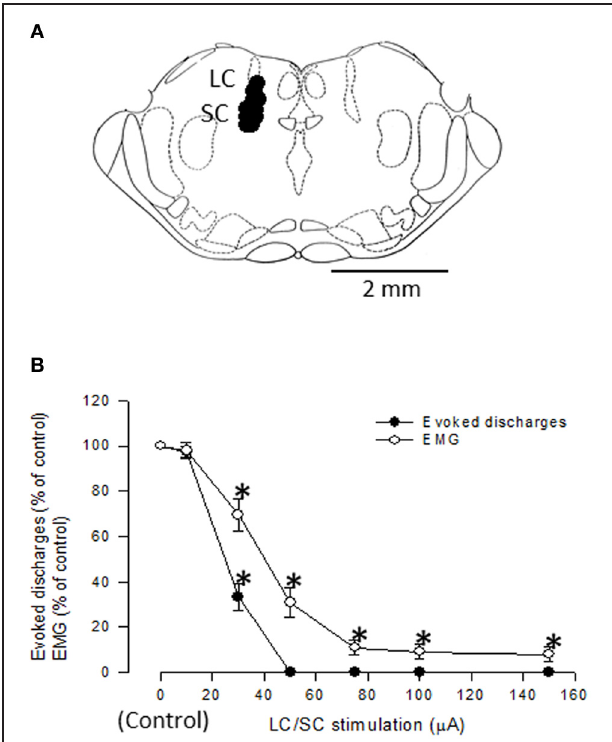
FIGURE 7 | (A) Localization of LC/SC stimulation sites ( n = 12). Each closed circle represents one animal. The rostrocaudal extension of the stimulation sites was 9 . 6 ± 0 . 1mm caudal to the bregma. Only data from rats in which the tip of the stimulating electrode was located within the LC/SC were adopted. (B) Graphs summarizing the effects of varying stimulus intensities of LC/SC stimulation on either the evoked discharge or the EMG activity ( n = 8). The evoked discharge and the EMG activity during LC/SC stimulation are expressed as a percentage of the value before LC/SC stimulation (control). Note that the inhibitory effect was different between the evoked discharge and the EMG. ∗ P < 0 . 05, significantly different from the control. (Tsuruoka et al.,